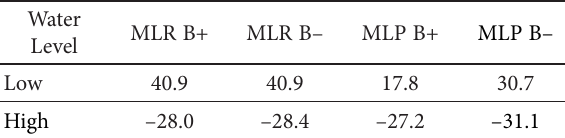
Table 6. Sum of relative errors for extreme water level values